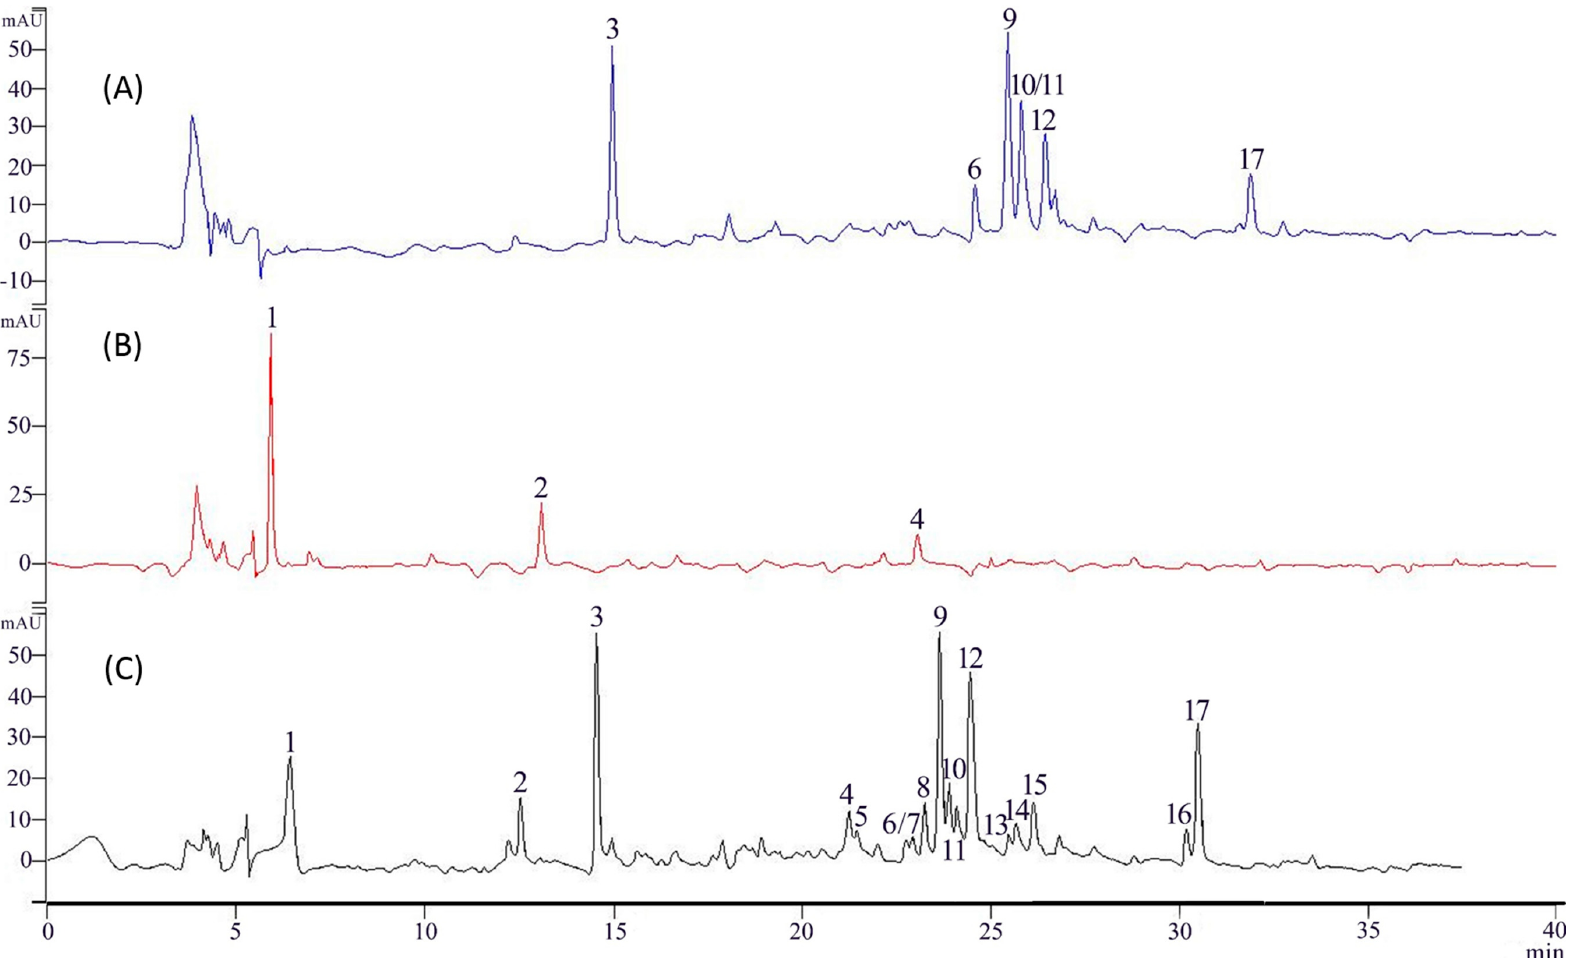
Figure 1. The HPLC chromatograms at 250 nm are as follows: ( A ) G. hypoleucum IMAC-Zn 1% HCl-MeOH eluent; ( B ) G. hypoleucum IMAC-Zn water eluent; ( C ) G. hypoleucum extract.